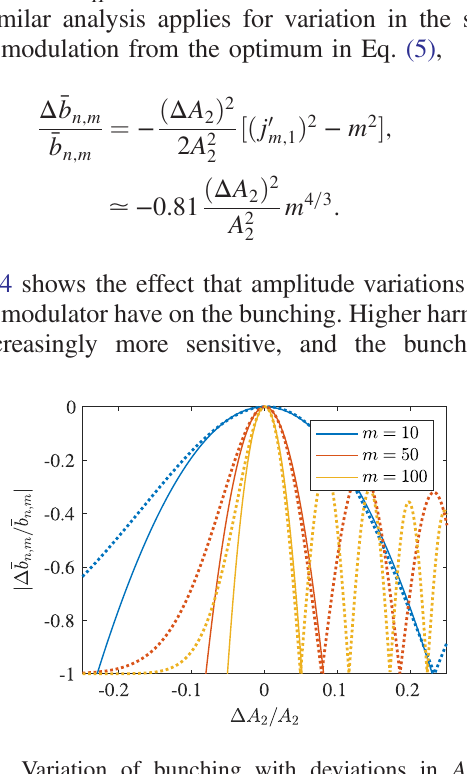
FIG. 4. Variation of bunching with deviations in A 2 from j 0 =aB 2 . Solid lines are from Eq. (7), dashed lines are from m; 1 exact